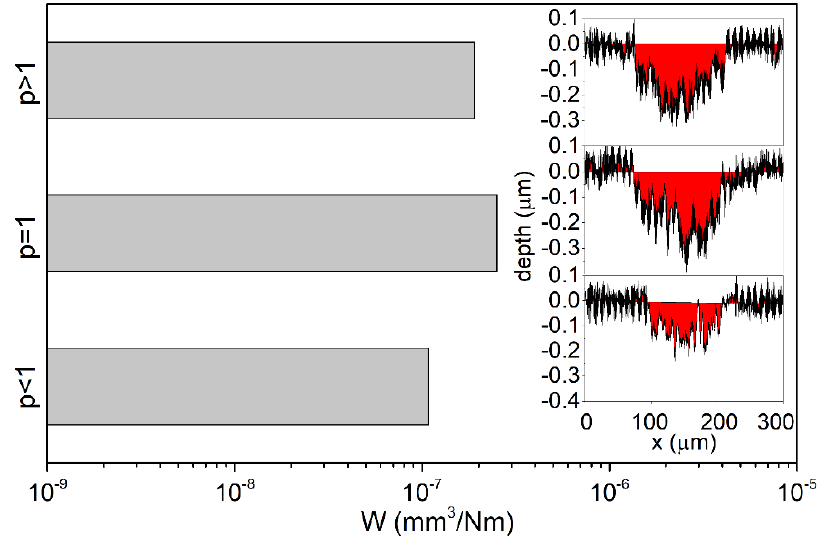
Figure 13. Wear ratio with cross-section of wear tracks for selected prototypes after ball-on-disc test, sliding distance 2000 m.